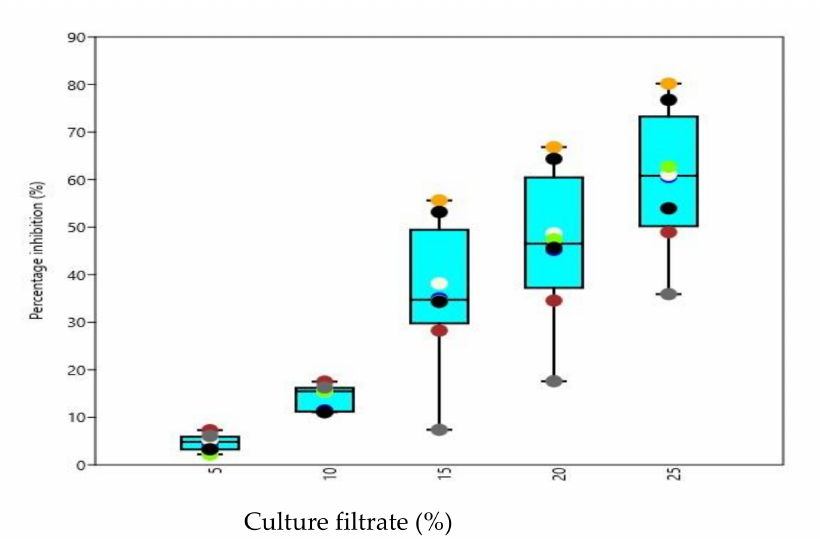
Figure 6. Box and Jitter plot representing Percentage inhibition of D. necatrix by various chitinase producing Trichoderma isolates. [Symbols in the plot represent: AT2: Orange; AT3: Black; AT7: Blue;